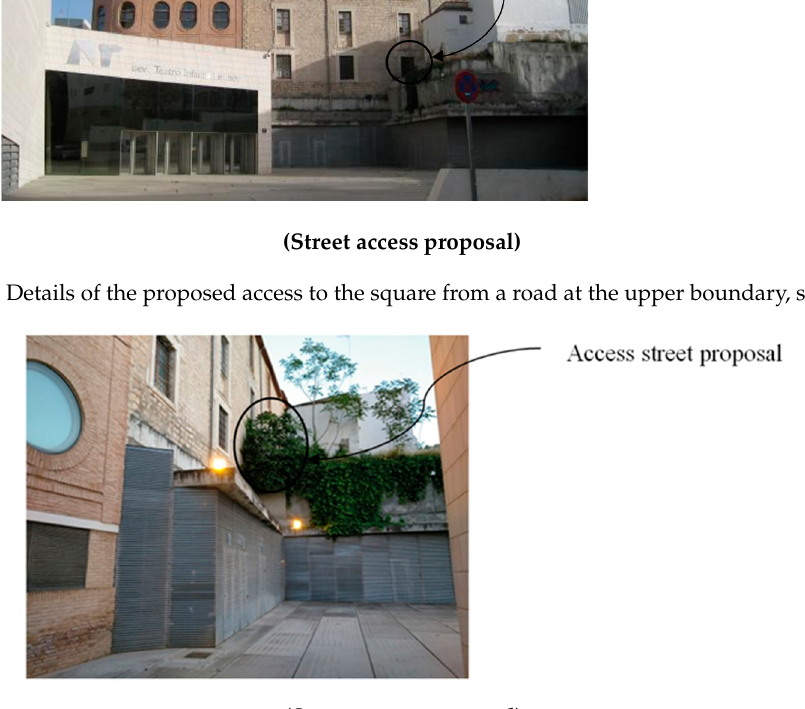
Figure 3. Details of the proposed access to the square from a road at the upper boundary, front view.